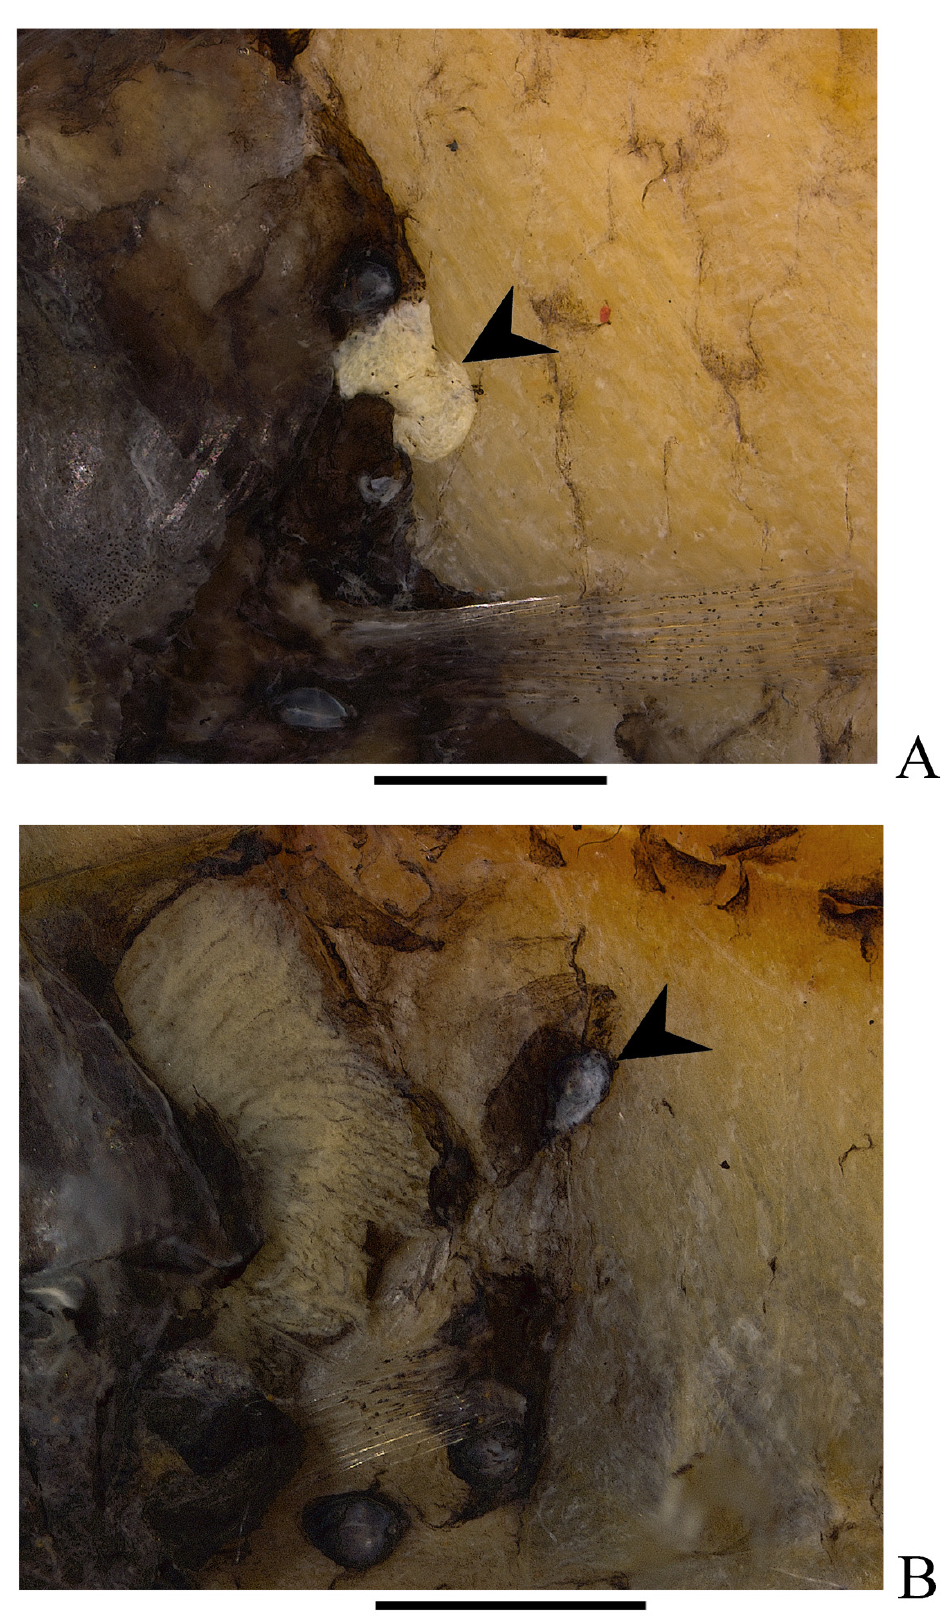
Figure 4. The luminous scale at PLO (arrowed). ( A ) Diaphus balanovi sp. nov., holotype, IORAS S.0124. ( B ) Diaphus kuroshio , IORAS S.0112. Scale bars: ( A ) 3 mm; ( B ) 1.5 mm.